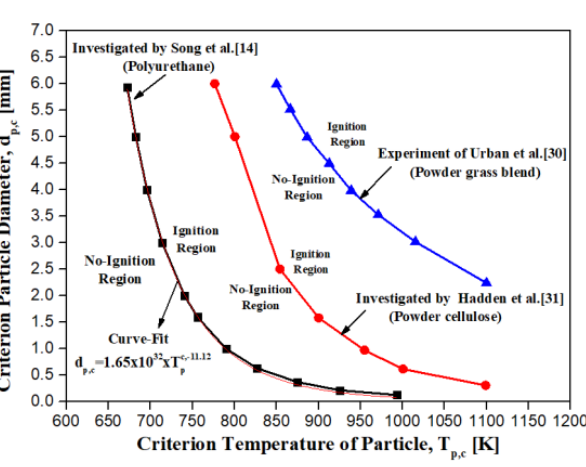
Figure 3. Investigation of the particle diameter and temperature criteria from previous results [14,30,31].